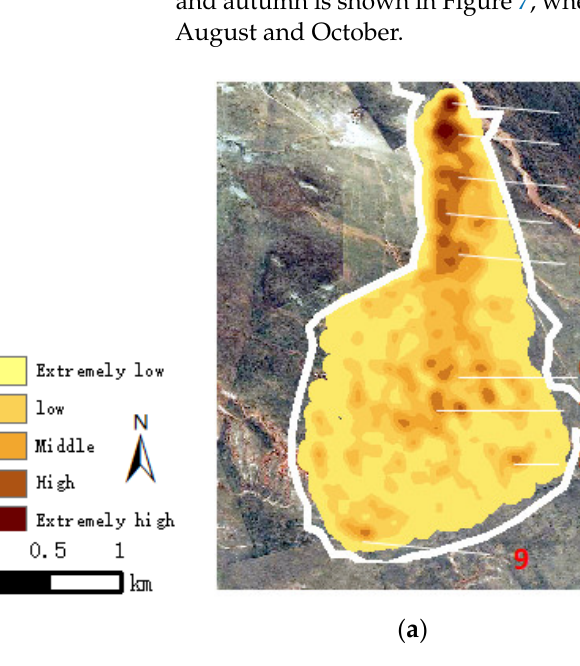
Figure 8. Schematic diagram of buffer and grid settings.